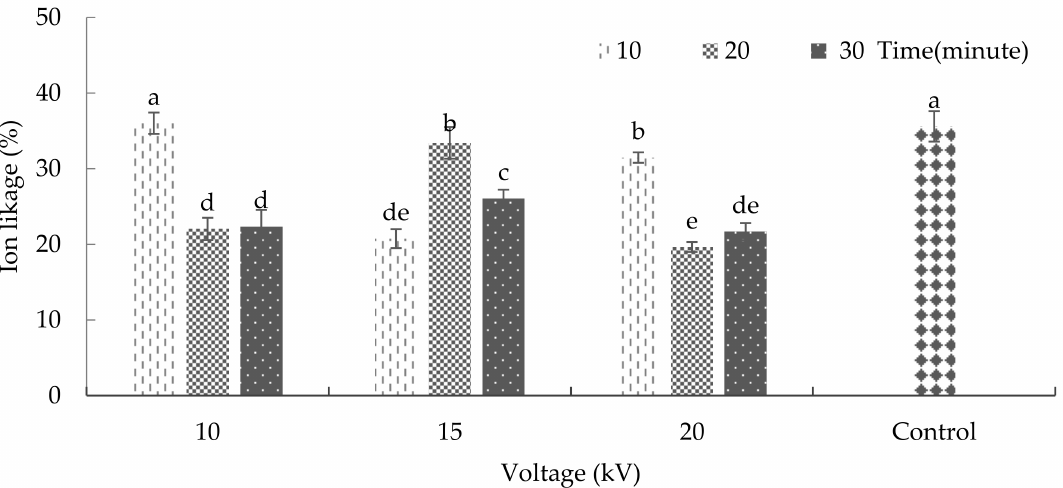
Figure 2. The effects of plasma on ion-leakage in basil. Error bars indicate standard error ( n = 3). Different lowercase letters denote statistical differences between treatment groups at the 5% level according to Duncan’s